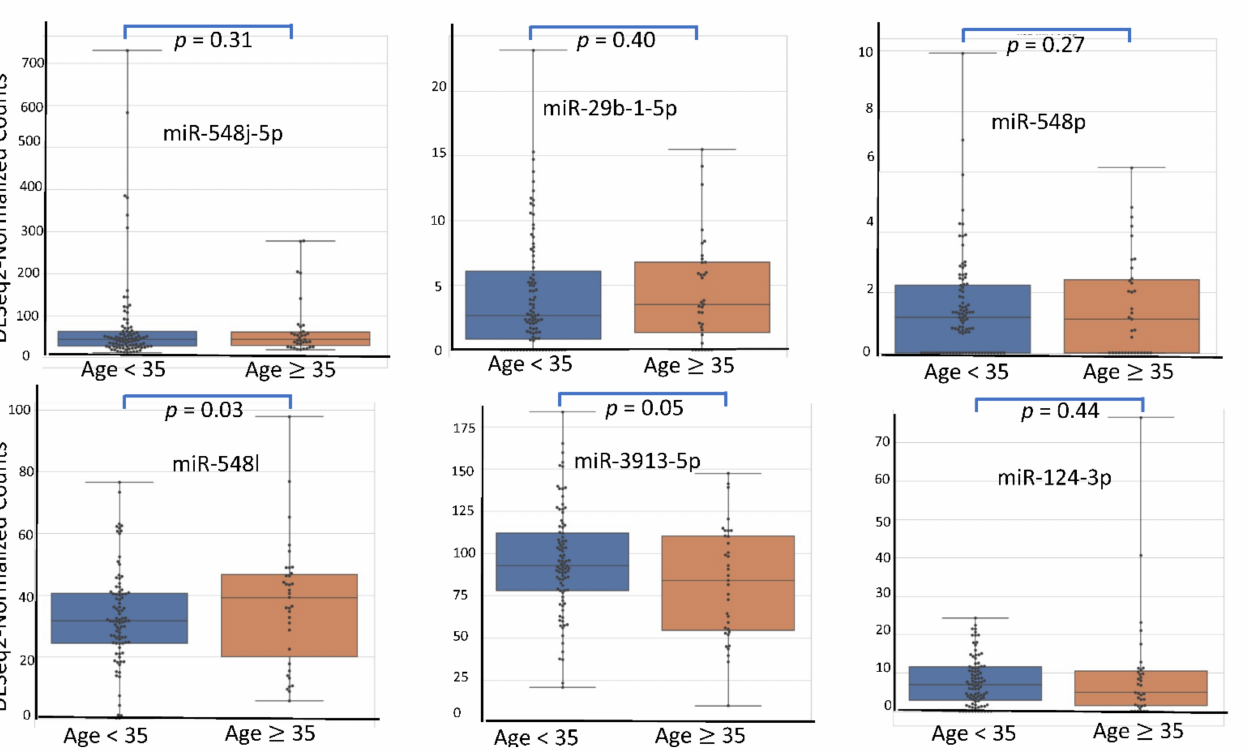
Figure 3. miRNA expression level according to